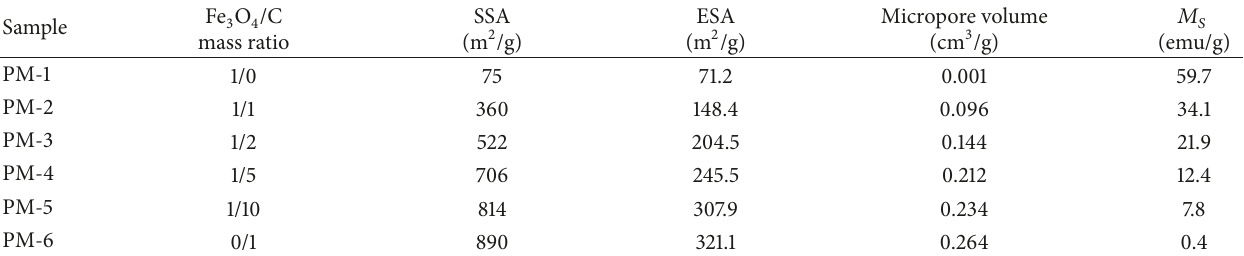
Table 1: Features of magnetite/carbon nanocomposites prepared by combustion synthesis [9].